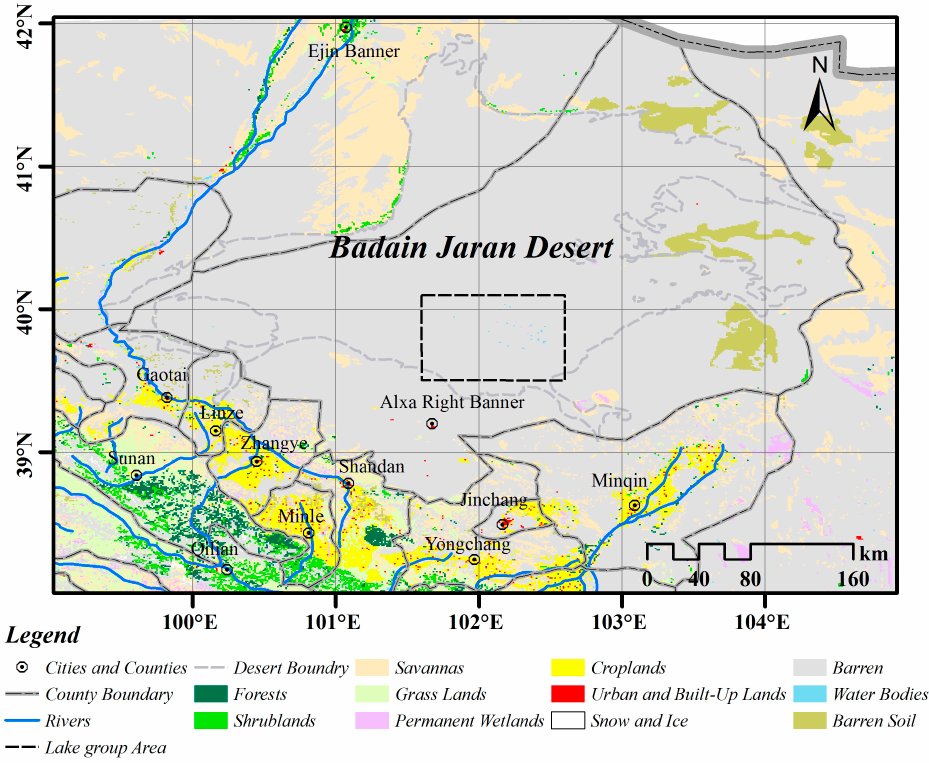
Figure 6. The land cover map of the study area in 2000.